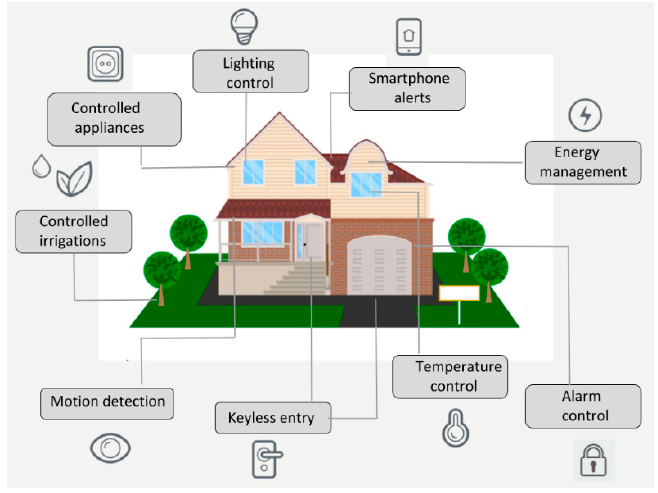
Figure 1. An IoT-based smart home depicting the use of smart sensing devices for different pur- poses.